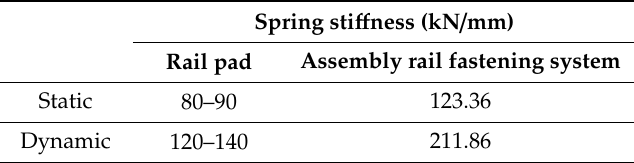
Table 3. Design values of the spring stiffness of the rail pad for the direct fixation track.